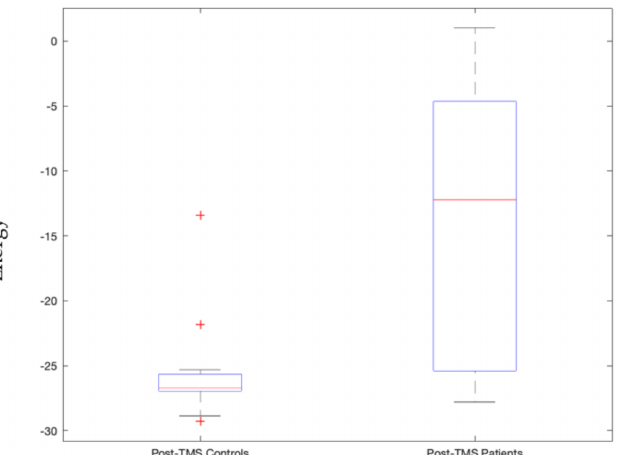
Figure 6. Energy values of controls significantly differed from patients during post-TMS subthreshold pulse stimulation condition at the vermis with a p -value = 0.0000099 for the active energy state of the frontoparietal network.